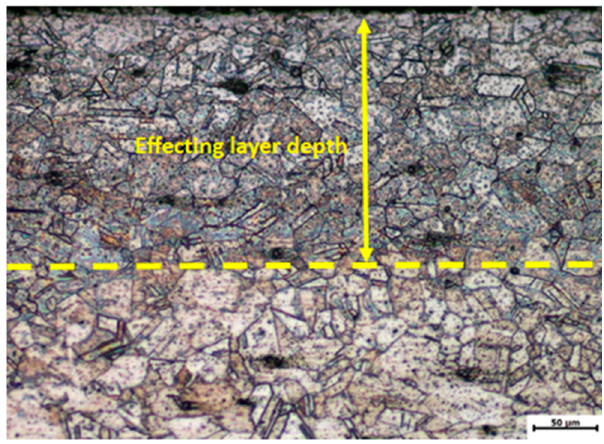
Figure 5. Cross ‐ sectional optical micrograph of the laser treated GH3039 superalloy sample. Figure 5. Cross-sectional optical micrograph of the laser treated GH3039 superalloy sample.